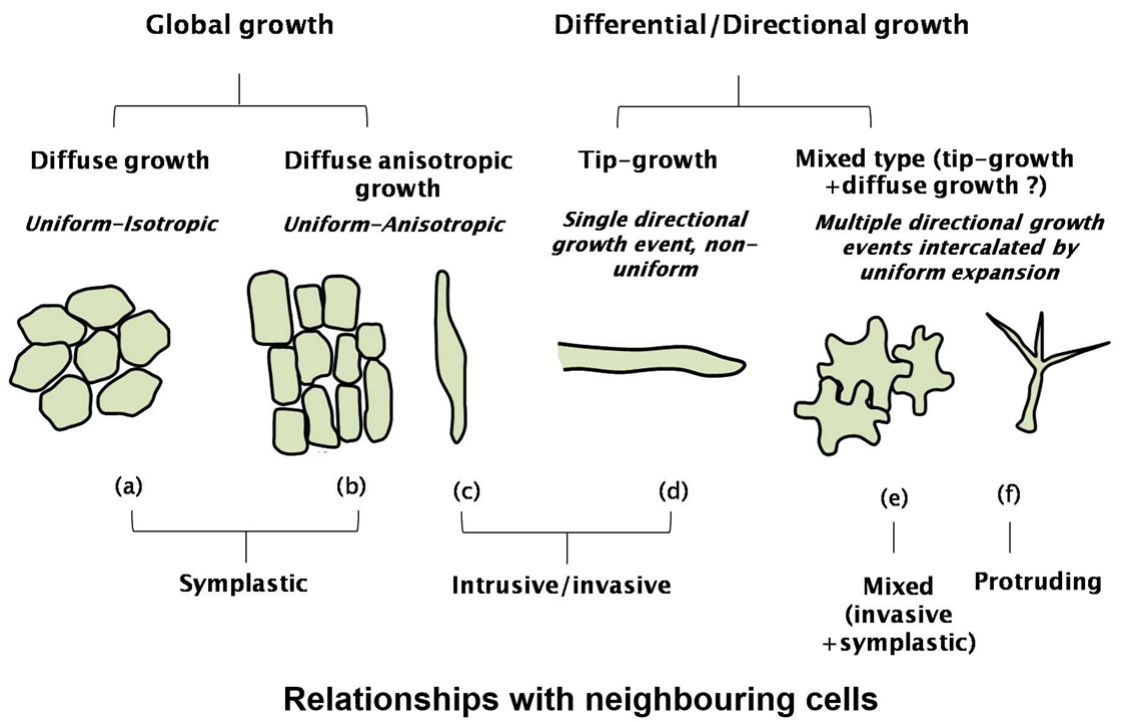
Figure 3. Cartoon depicting the two main plant cell growth events: global and differential/directional growth. Details concerning the cell types ( a ) fruit parenchyma cells; ( b ) shoot/root epidermal cells; ( c ) bast fibre; ( d ) pollen tube; ( e ) leaf pavement cells; ( f ) trichome and the relationship with the neighbouring cells are added to show the different expansion modalities displayed by plant cells. The question mark indicating the mixed-type growth refers to a hypothetical mechanism involving both tip- and diffuse